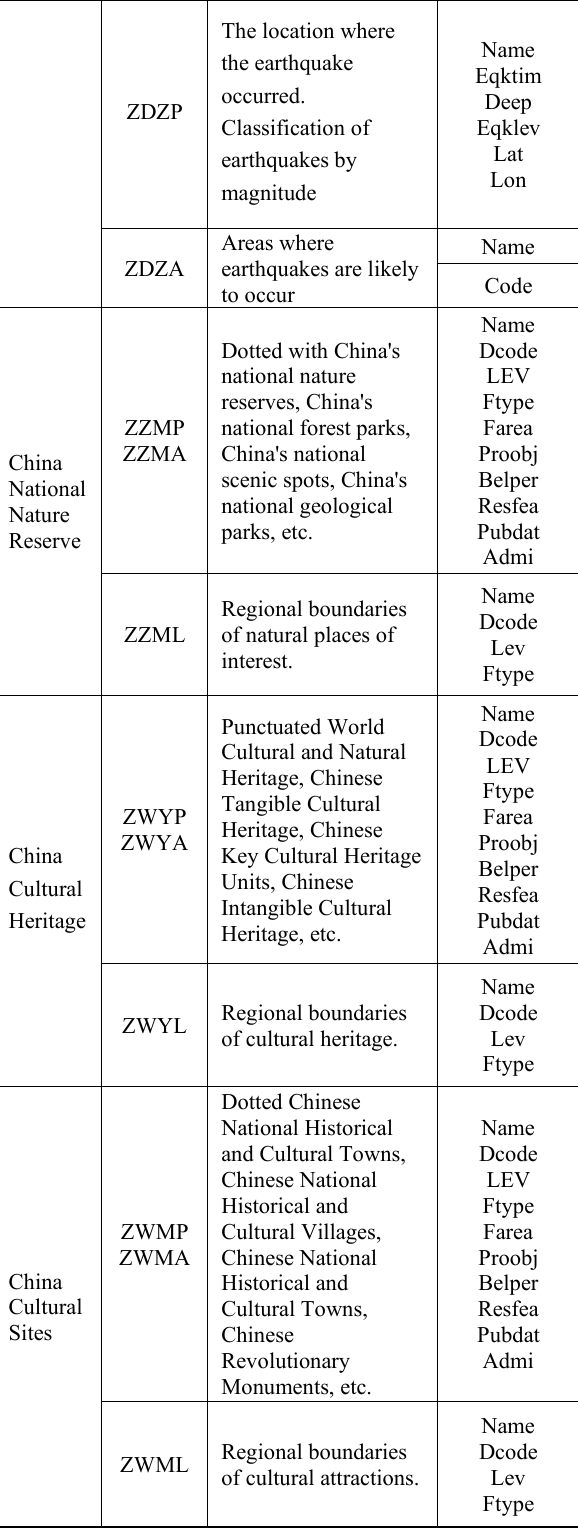
Table 1 . Thematic Data Layer and Attribute Table Structure.